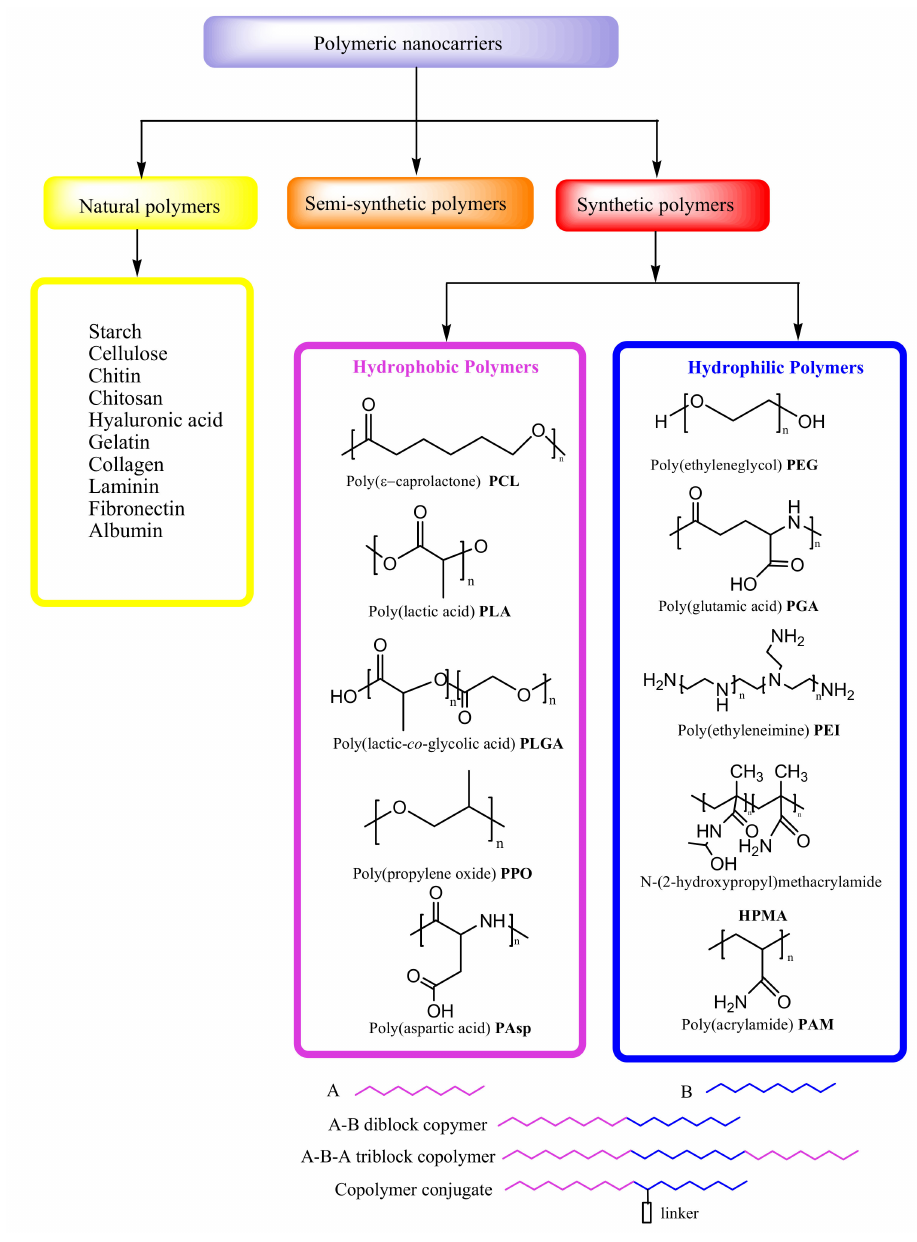
Figure 2. Types of polymeric